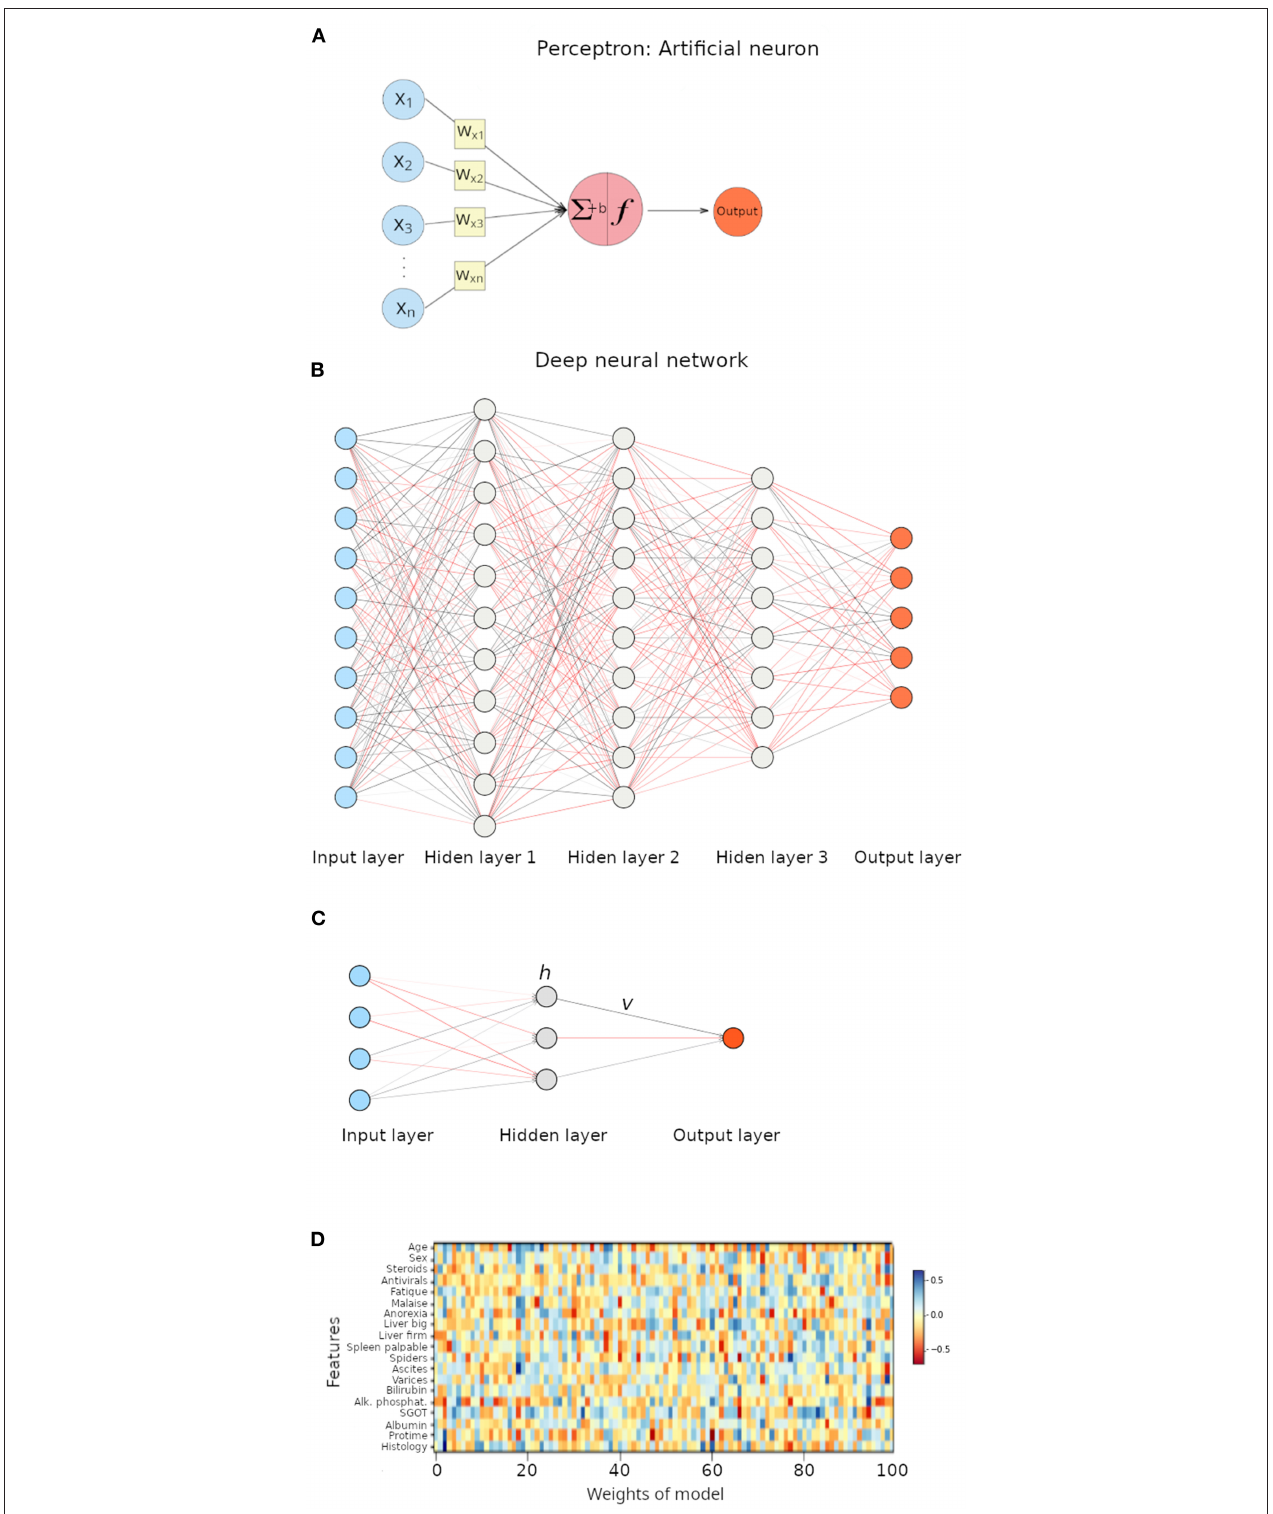
represents the weighted sum, f represent the P